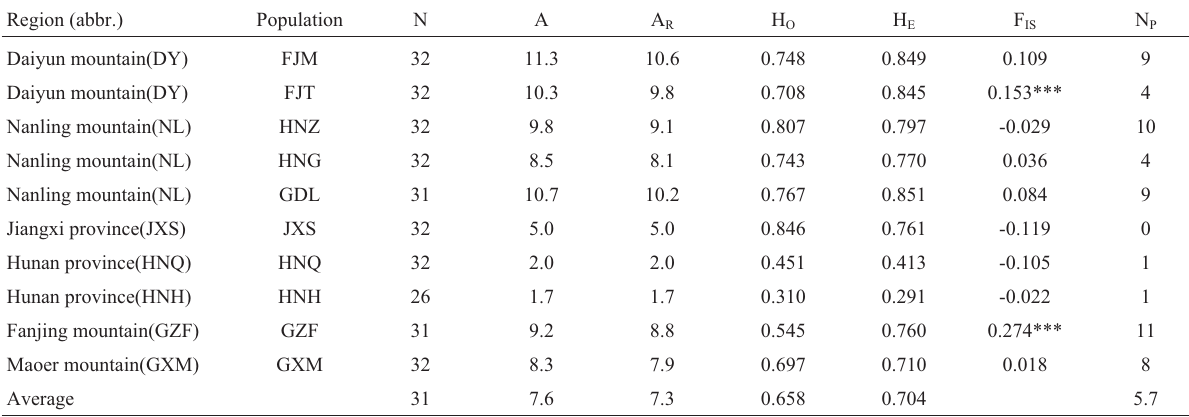
Table 1 - Genetic diversity within populations in Nothotsuga longibracteata . Region (abbr.)